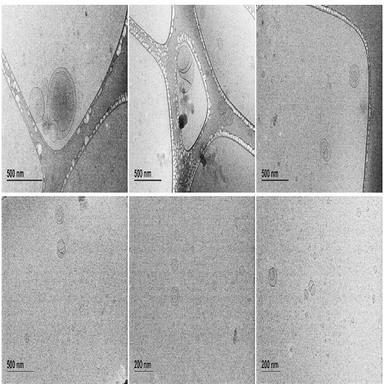
Cryo-TEM micrographs of liposomes.